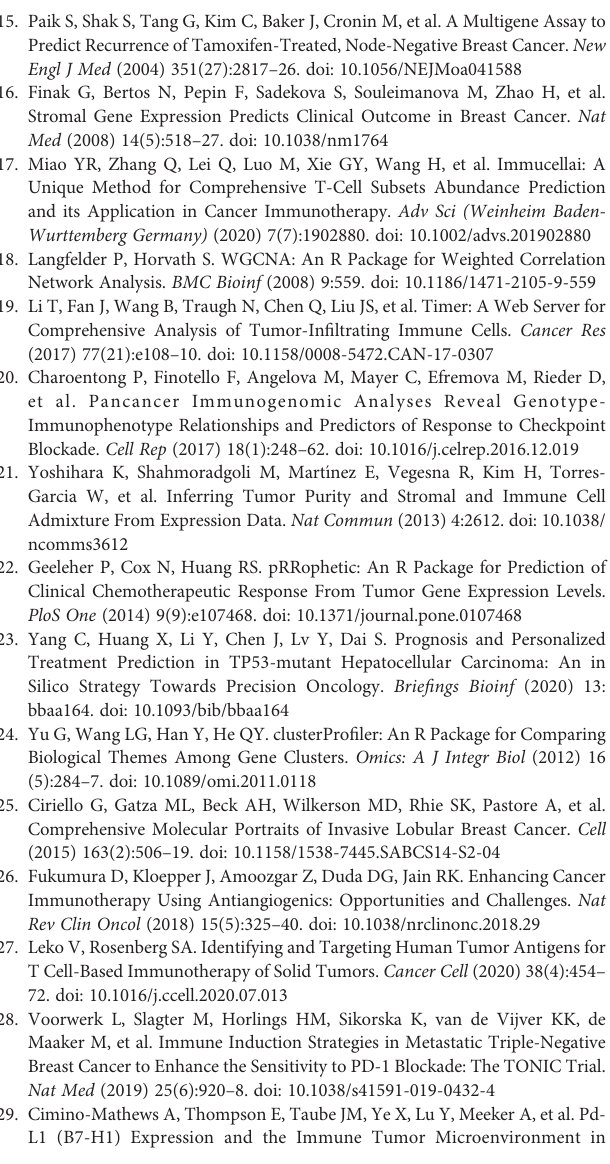
Supplementary Figure 2 | GO analysis of genes in the red module. Supplementary Figure 3 | Correlation analysis between protective immune cells and IRS in TCGA and METABRIC cohorts. Supplementary Figure 4 | Results of the clinicopathological feature univariate and multivariate Cox regression analyses of OS in the luminal subtype of breast cancer in TCGA database. Supplementary Figure 5 | Results of the clinicopathological feature univariate and multivariate Cox regression analyses of OS in the basal-like subtype of breast cancer in TCGA database. Supplementary Figure 6 | Results of the clinicopathological feature univariate and multivariate Cox regression analyses of OS in the HER2 subtype of breast cancer in TCGA